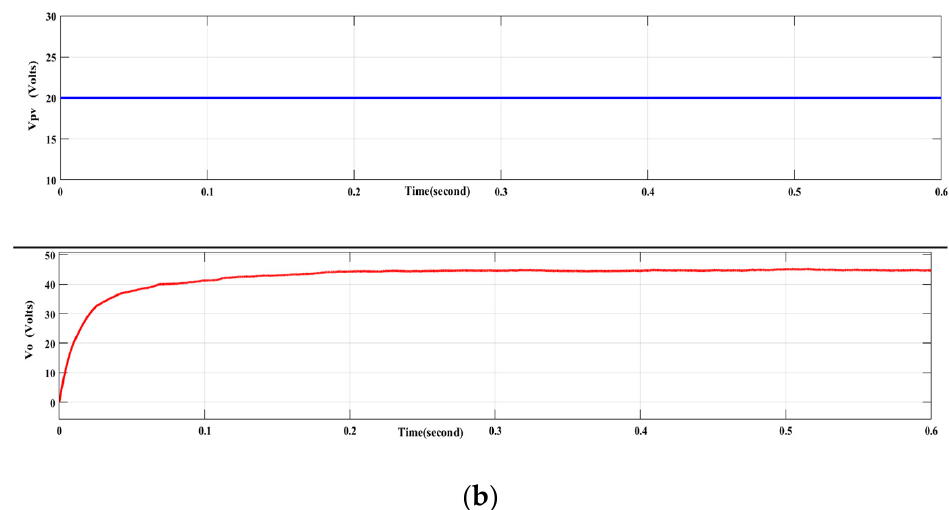
Figure 7. Simulation result of the proposed IIABB converter for solar PV module input voltage V pv of 20 V and corresponding output voltage V o = 48 V and number of connected inductors N = 2 with duty cycle 0.55 ( a ) gate pulse waveform where S A and S C are in operating condition and S B and S D are not operating, and ( b ) the V pv and output voltage V o .